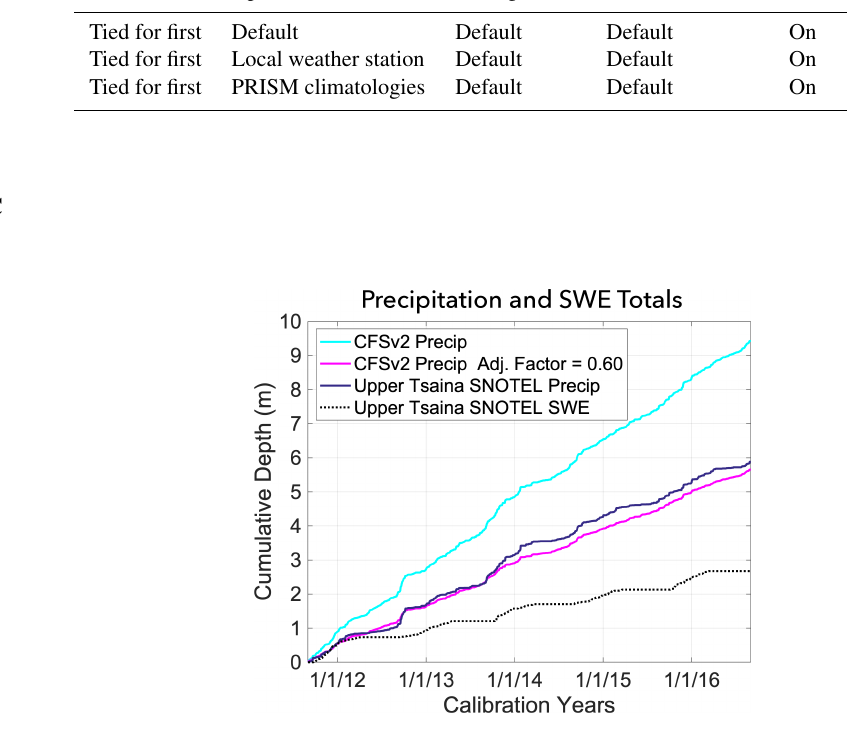
Figure C1. Precipitation totals at the Upper Tsaina SNOTEL station compared to the CFSv2-forced model totals and the CFSv2-forced model totals with a precipitation adjustment factor. This overestimation of precipitation by the reanalysis product is a major factor in the quality of the calibration